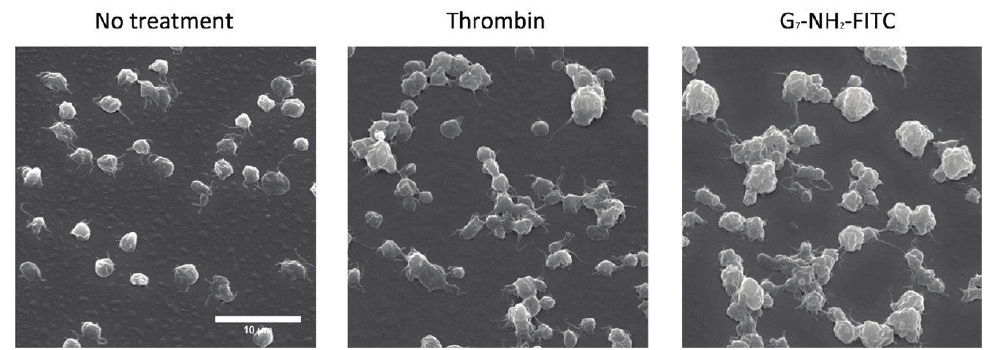
Figure 3. SEM images of platelets, taken at 2500× magnification, after treatment with saline, thrombin (0.1 U/mL) or G7-NH 2 dendrimer (100 μ g/mL). Notice the disheveled membrane morphology as well as increased number and size of platelet aggregates after treatment of platelets with G7-NH 2 dendrimer (right hand panel) [63].